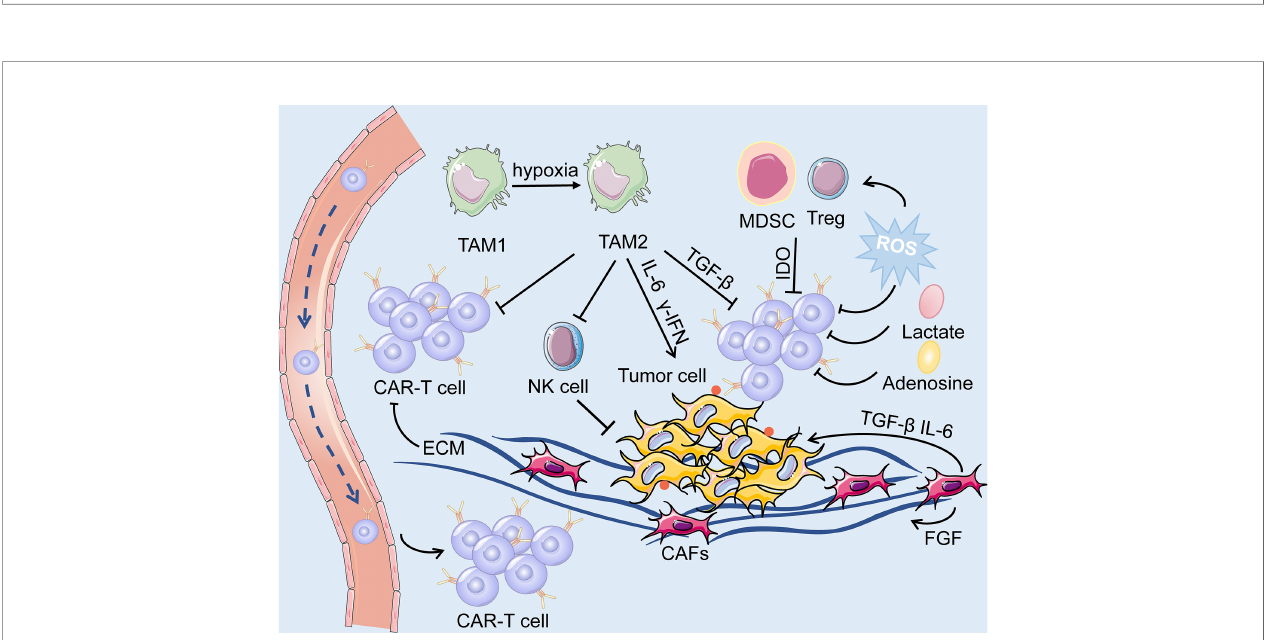
FIGURE 6 | The TME is primarily composed of tumor cells, immune cells, immunosuppressive cells (including TAM, MDSC and Treg) and cytokines, CAFs, ECM and dysregulated tumor vasculatures. On the one hand, ECM produced by CAFs forms a physical barrier, impairing the in fi ltration of the CAR-T cells. On the other hand, the soluble cytokines secreted by the CAFs mediate immuno-suppressive responses, and consequently, facilitate the survival of tumor cells. The hypoxic and acidic environment directly deteriorate the metabolism of T cells while activating suppressive Tregs, leading to immunosuppression of CAR-T cells.